Question: Identify the chart type used in this figure.
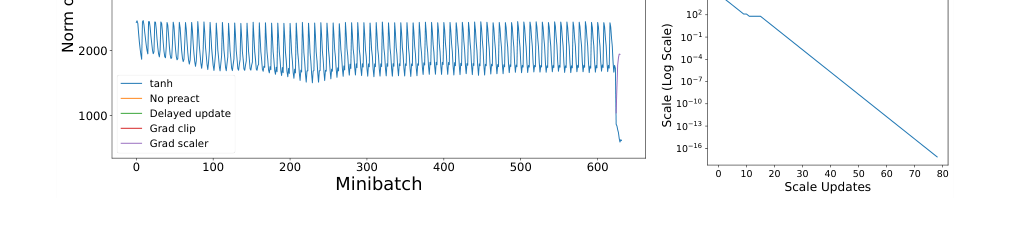
Answer: line